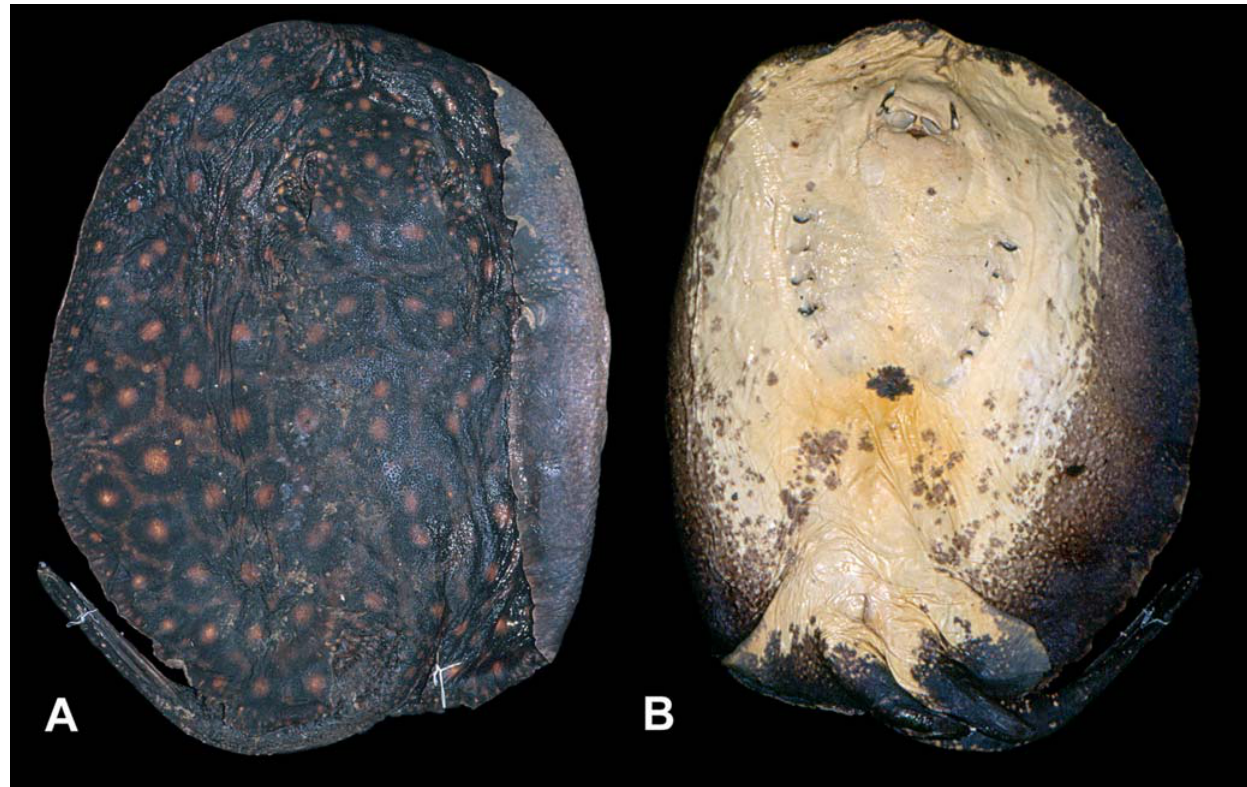
Fig. 4. Potamotrygon boesemani . Dorsal ( A ) and ventral ( B ) views of paratype (USNM 388849, male, 413 mm DW), from Corantijn river.